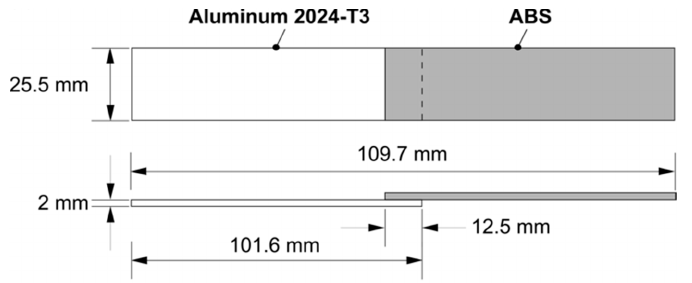
Figure 2. Schematic of lap shear testing specimen geometry for the AddJoining hybrid joints.